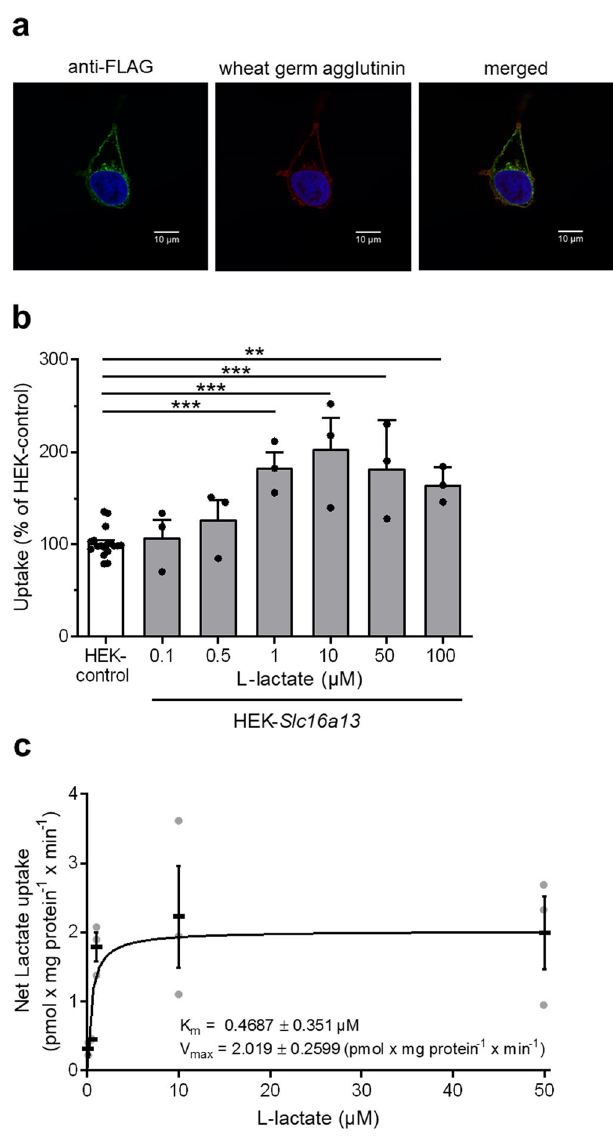
Fig. 2 Mouse Slc16a13 cellular localization and transport activity. a Immuno fl uorescence co-staining of the plasma membrane marker wheat germ agglutinin and FLAG-tagged Slc16a13 in HEK- Slc16a13-FLAG cells. One representative staining is shown. b L -lactate uptake into HEK-control and HEK- Slc16a13 cells ( n = 3 for each concentration). Bars represent means ± SEM. ** p < 0.01, *** p < 0.001 determined using one-way ANOVA followed by Dunnett ’ s multiple comparison test. c Net L -lactate uptake as the difference between the uptake into HEK-control and HEK- Slc16a13 cells. Nonlinear regression curve and means ± SEM are